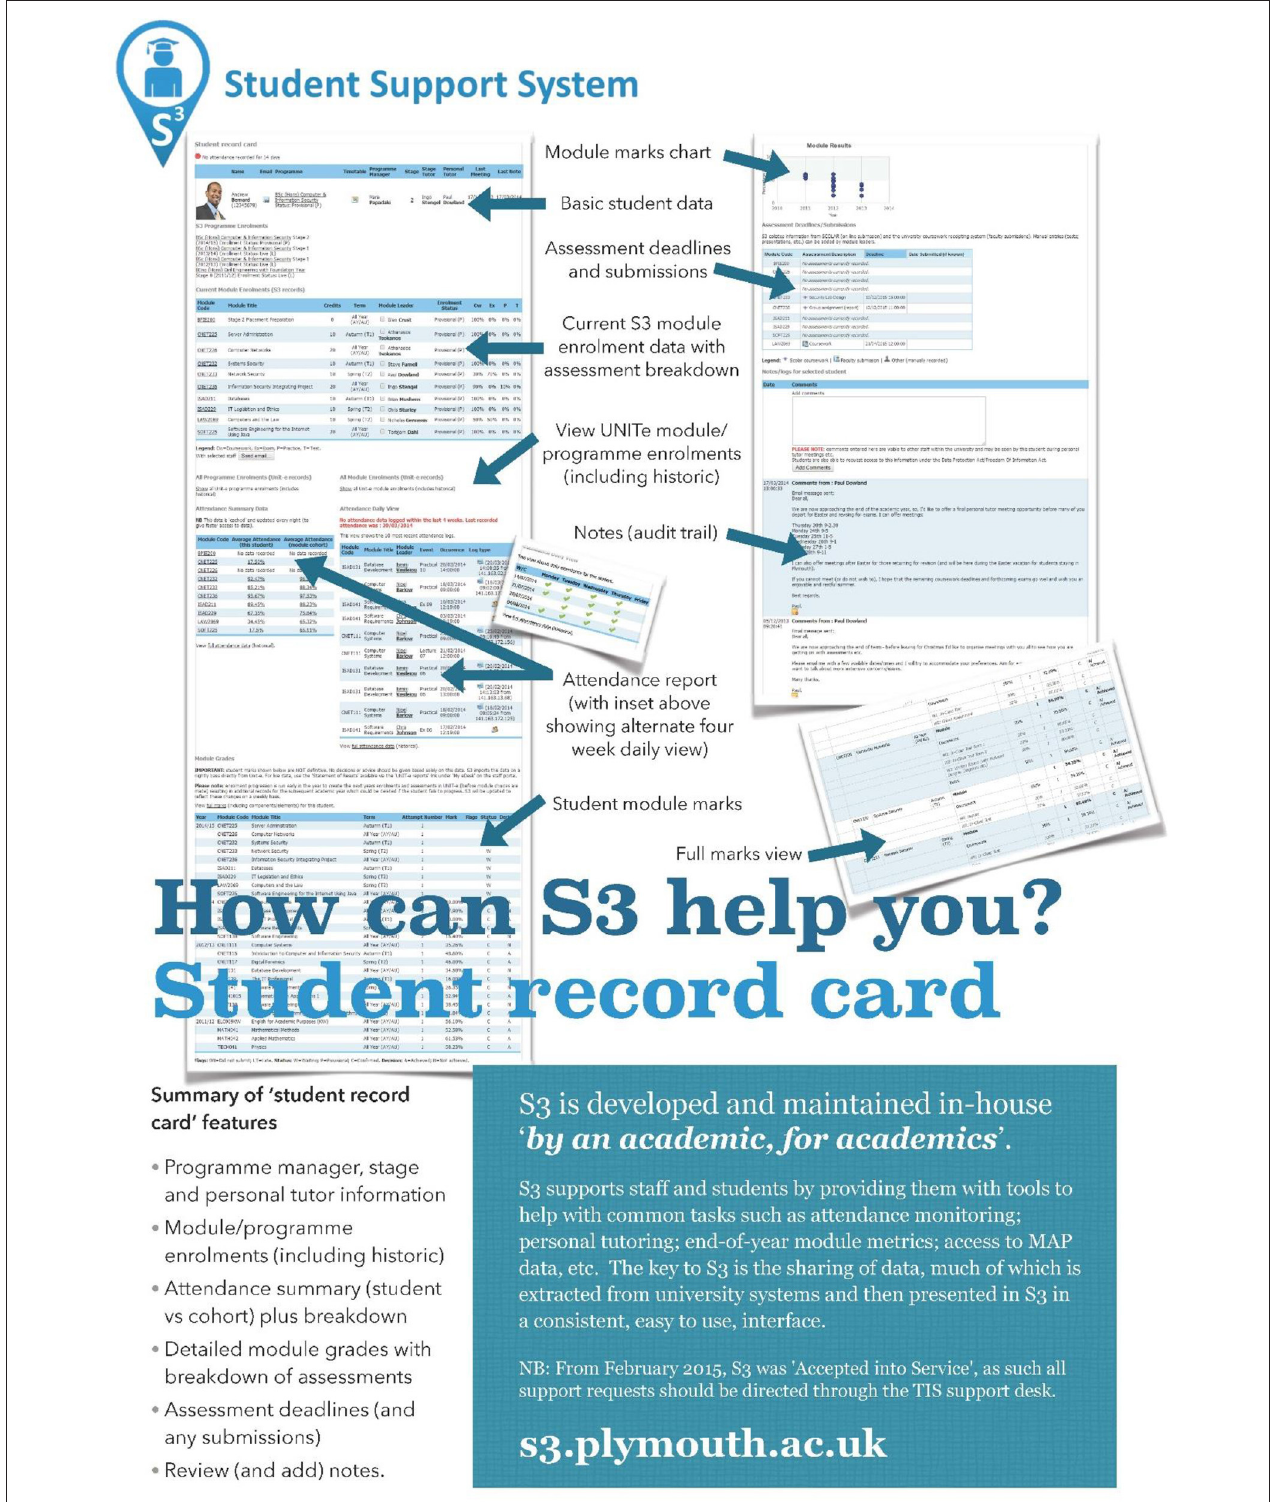
FIGURE A1 | How can S3 help you? Student support